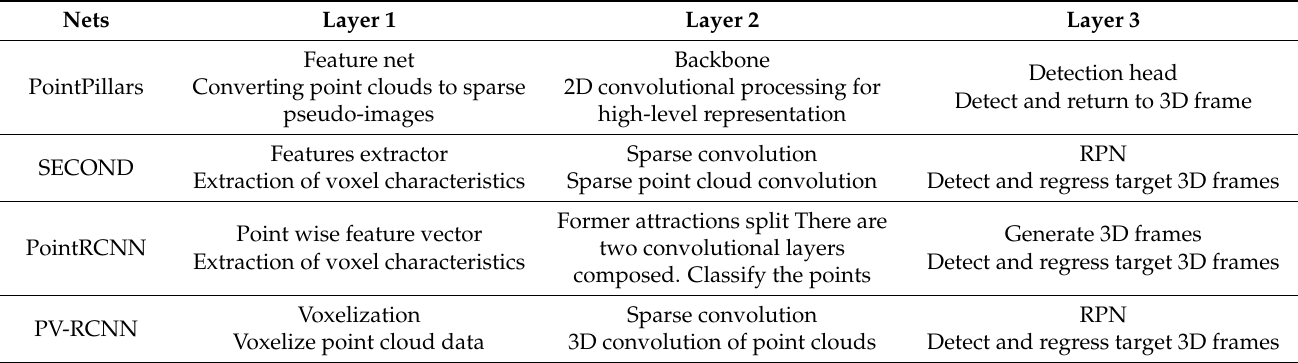
Table 1. Network structure and function overview.